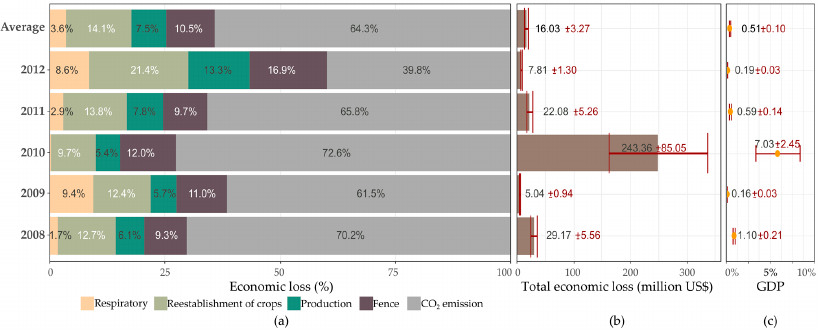
Figure 8. Percentage of economic loss by type of damage ( a ), total economic loss ( b ), and GDP equivalence ( c ) by year.